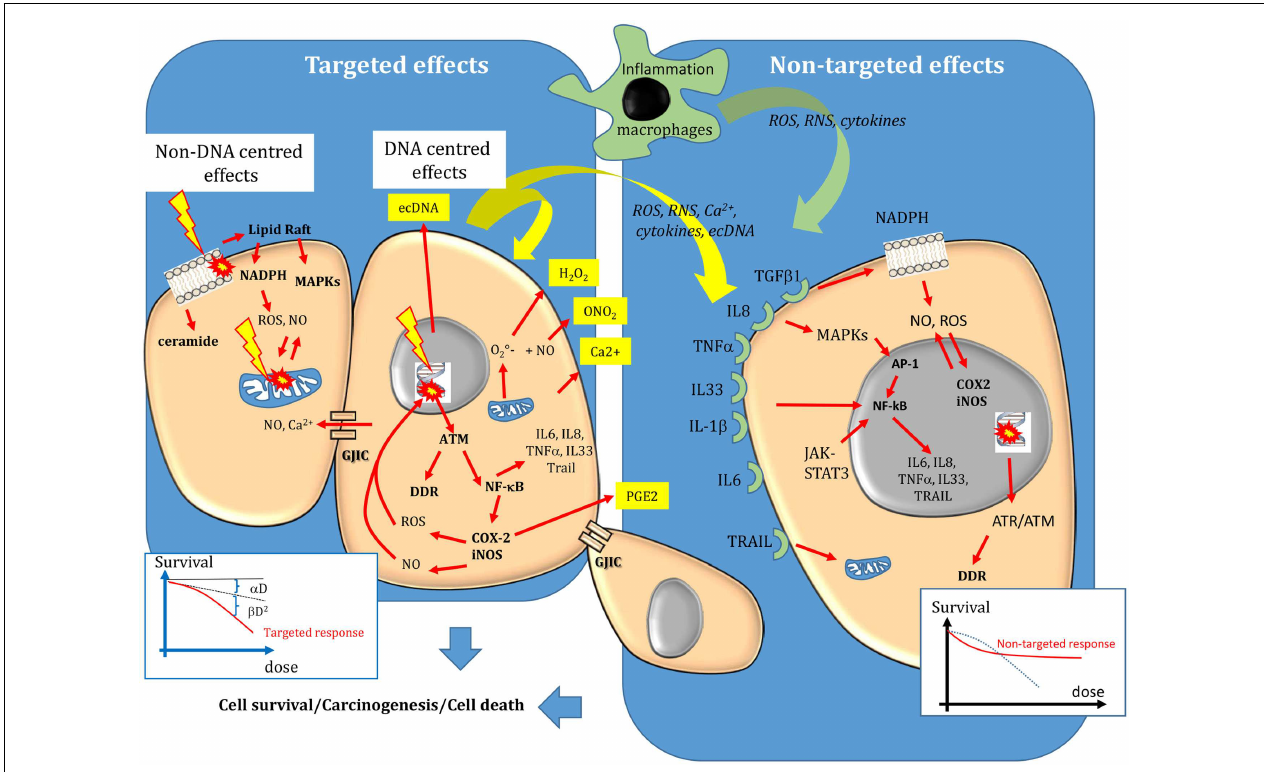
and the cell membrane are the main sensitive targets of radiation. Following targeted and non-targeted effects, cells can survive (lesions are effectively repaired), they can die (lesions are not repaired) or they can be transformed. The dose–effect relationship of targeted effects is commonly fitted by linear or linear-quadratic models. A saturation of the response to non-targeted effects has been described. For more details, see the main